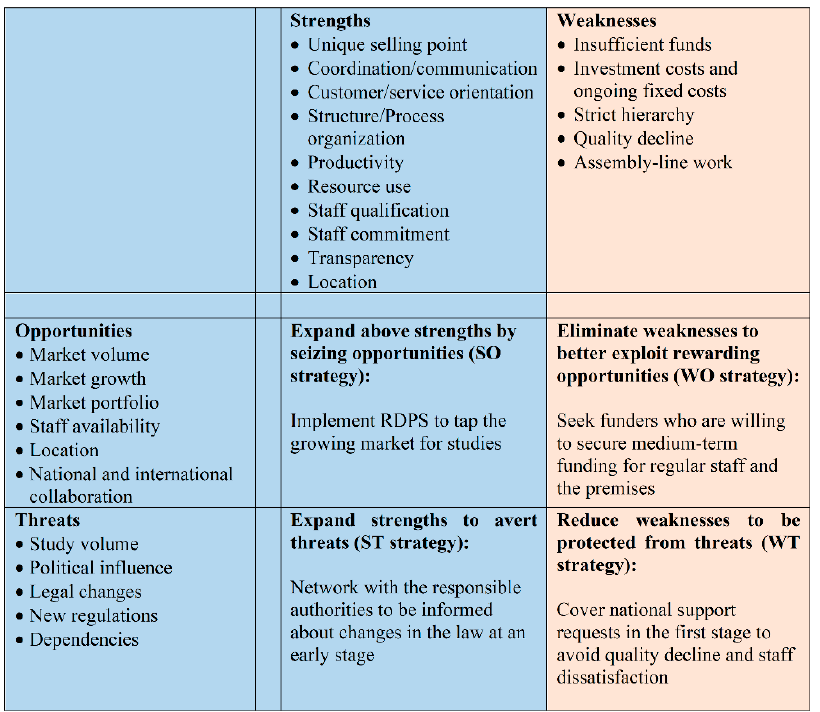
Figure 5. RDPS SWOT matrix.